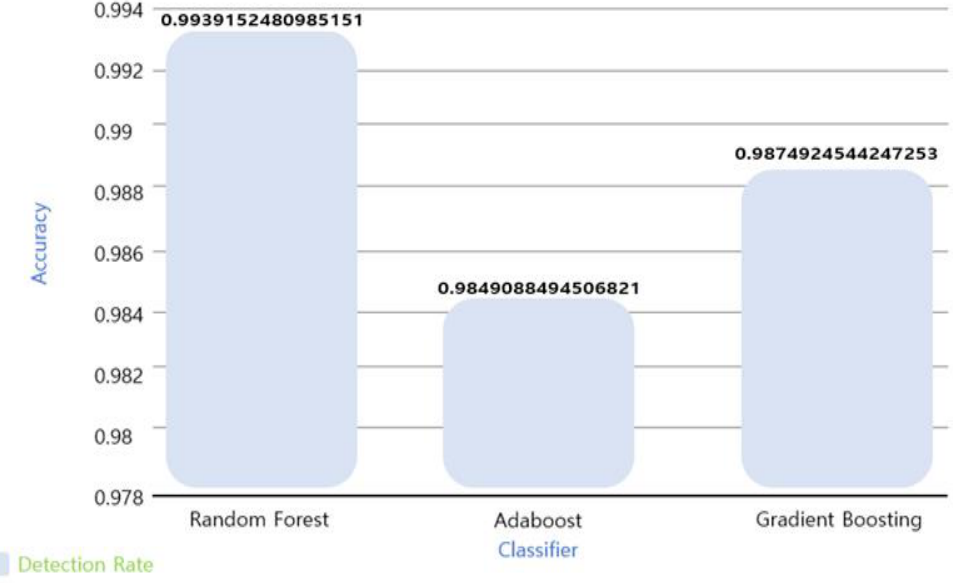
Figure 11. Classifier training results.